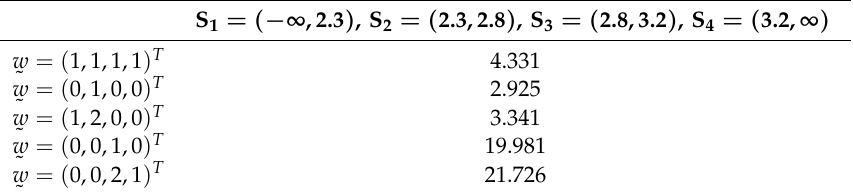
Table 9. CWKL divergence between π 2 and π 3